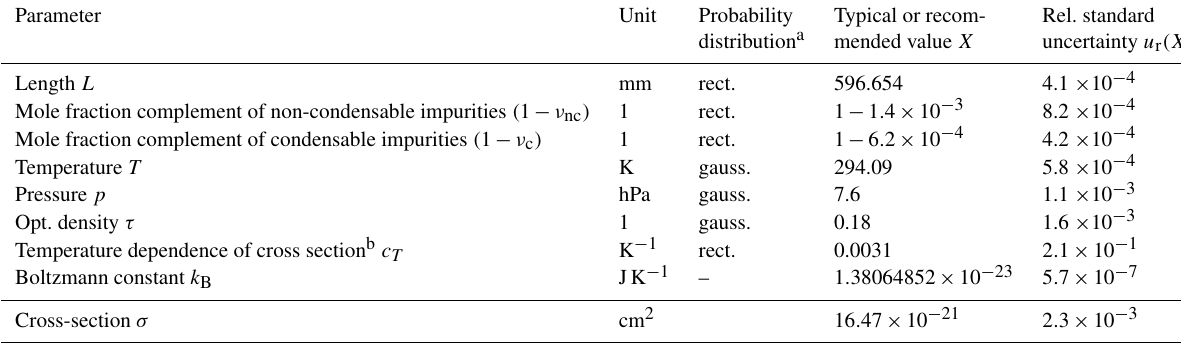
Table 2. Uncertainty budget of a single absorption cross-section measurement at average pressure Parameter Unit